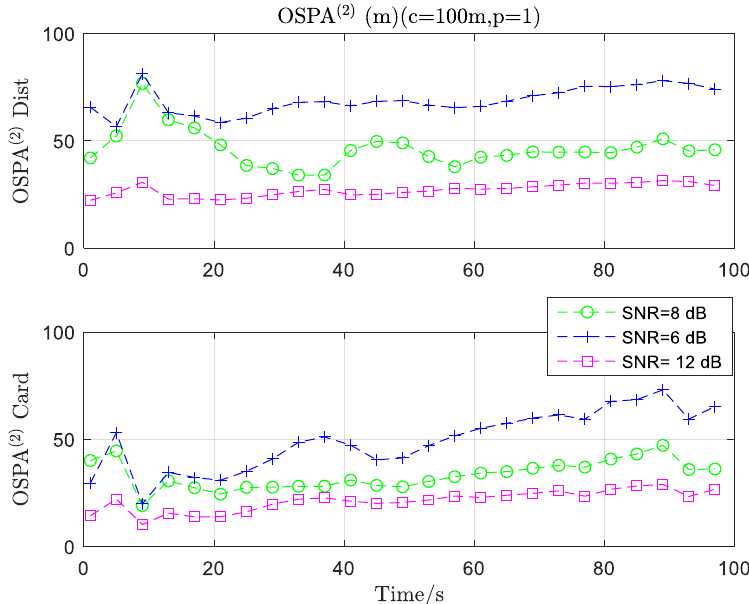
Figure 10. The error curves of the proposed algorithm for different SNRs.